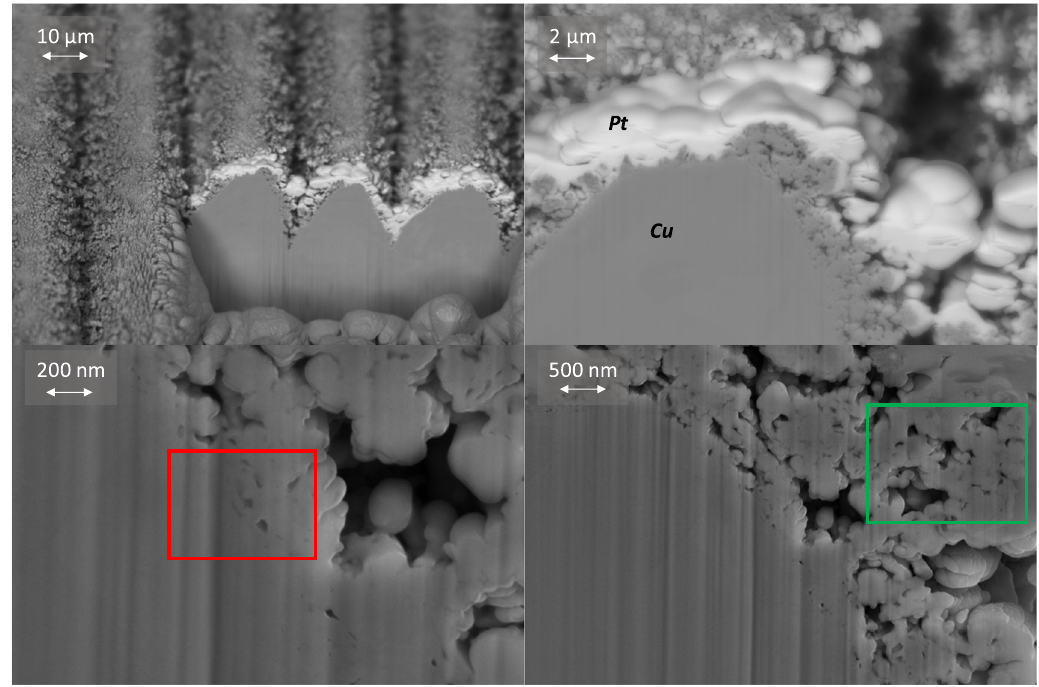
FIG. 4. Comprehensive view of a FIB cross section of a LH sample analogous to Fig. 3(b), at progressive magnifications clockwise from top left. The platinum top layer, of lighter color in the images, is added as a part of the FIB etching process, to improve image quality minimizing artifacts. The colored rectangles indicate the different regions mentioned in the